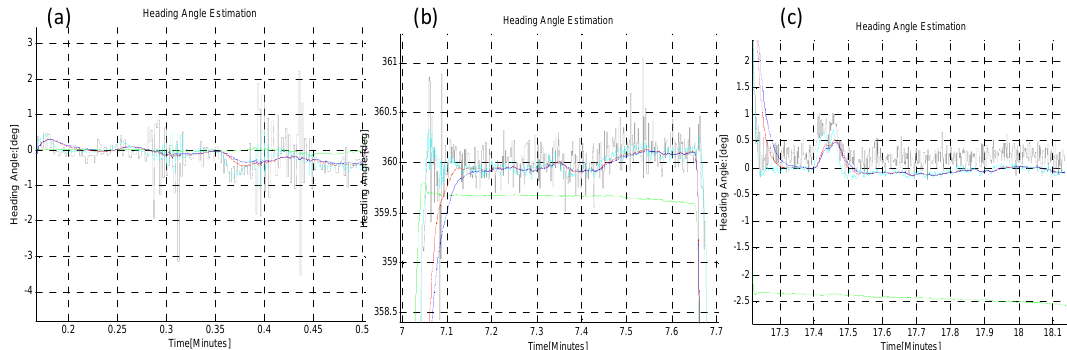
Figure 16. Zoom ‐ in view in TiP test (B ‐ ii), with small increments (20°), with both CW and CCW rotation through 0~360°, at the start ( a ); mid ( b ) and end (c ) point of rotation. Clearly, the q ‐ Method has large errors as compared to EASI.